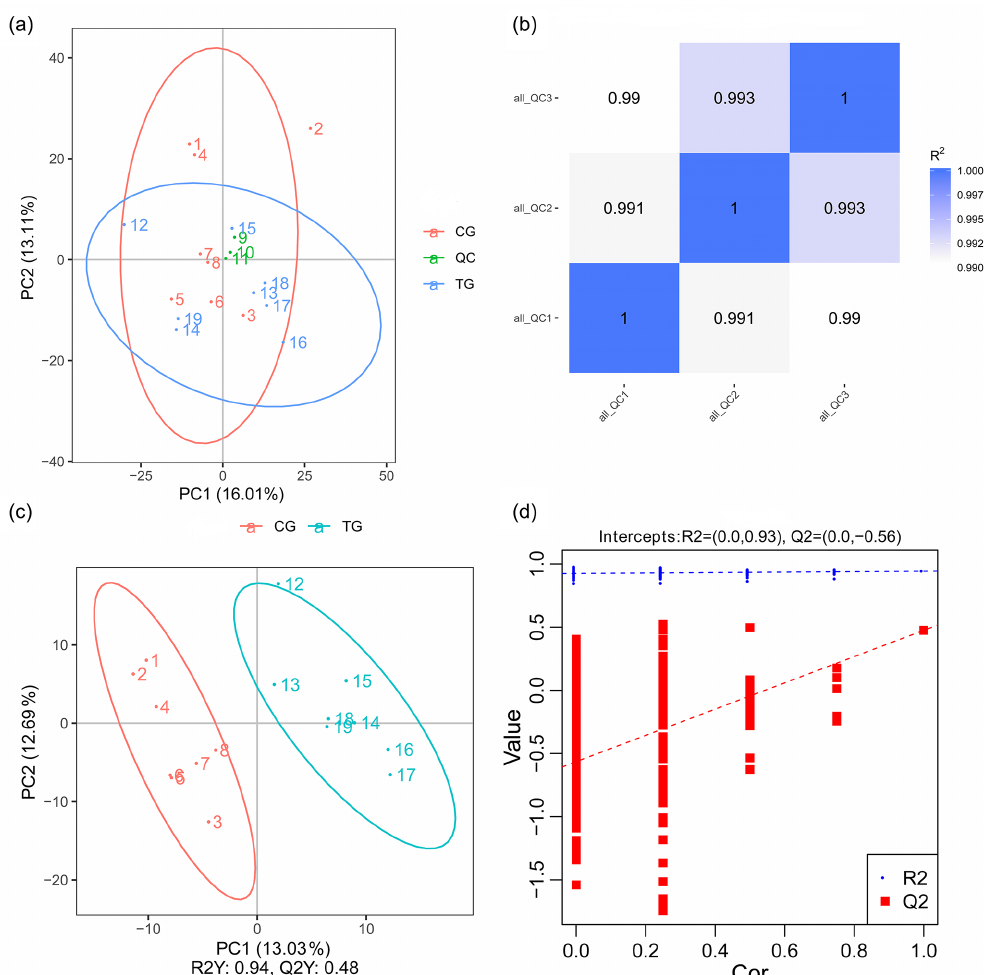
Figure 3. PCA and OPLS-DA score plots. (a) PCA score plots for consecutively analyzed quality control (QC) samples. (b) The Pearson correlation coefficient of three QC samples. (c) OPLS-DA score plots discriminating the control group (CG) and treatment group (TG). (d) Permutation test for the OPLS-DA model